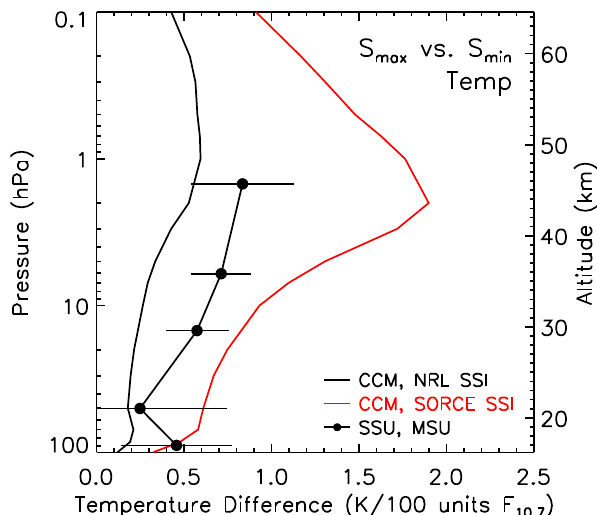
Fig. 7. Same as Fig. 4, but for temperature. SSU=Stratospheric Sounding Unit; MSU=Microwave Sounding Unit; data from (Austin et al., 2008, Fig.